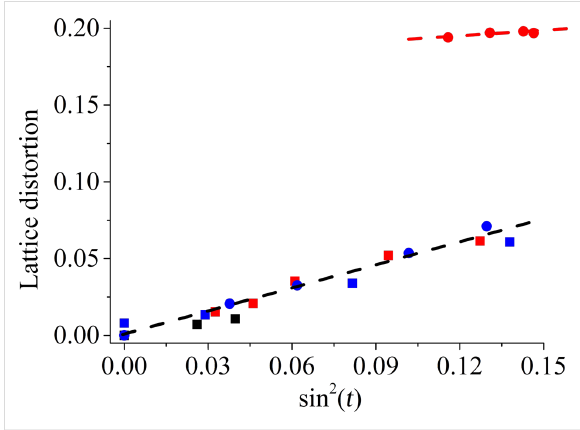
Figure 8: Lattice distortion as a function of sin 2 ( t ) of C1P monolayers at 20 °C on (red circle) pH 9 with calcium; (red square) pH 9 without calcium; (blue circle) pH 4 with calcium; (blue square) pH 4 without calcium; and (black square) on